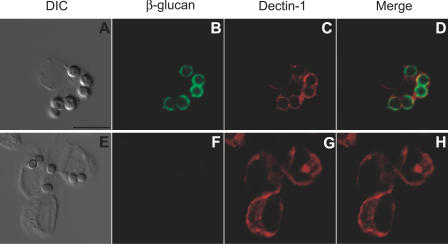
Dectin-1 Is Recruited to AMØ Phagosomes Containing Swollen Conidia with Surface-Exposed β-Glucans(A–H) AMØs were harvested from C57BL/6 mice 45 min after intratracheal instillation of 107 heat-killed swollen conidia (A–D) or heat-killed resting conidia (E–H), processed at 4 °C, and immunostained for ingested conidial β-glucans with mAb 744, followed by a FITC-coupled anti-mouse IgM (B and F) and for Dectin-1 (C and G) with goat anti-Dectin polyclonal antibodies, followed by Alexa Fluor 594-coupled anti-goat IgG. AMØs were examined by DIC microscopy (A and E) and epifluorescence confocal microscopy (B–D and F–H).(D and H) Merged images of β-glucan and Dectin-1 immunofluorescence.Scale bar = 10 μm.